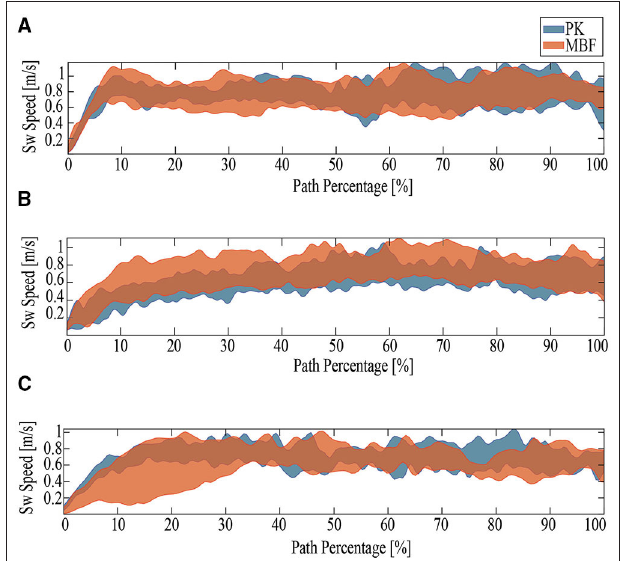
FIGURE 7 | The behavior of the results obtained for walker speed. PK stands for older adults with Parkinson’s disease and MJF stands for a group of older adults with base, joint and fracture diseases. (A) Ramp Up Test. (B) Ramp Down Test. (C) Timed Up and Go.